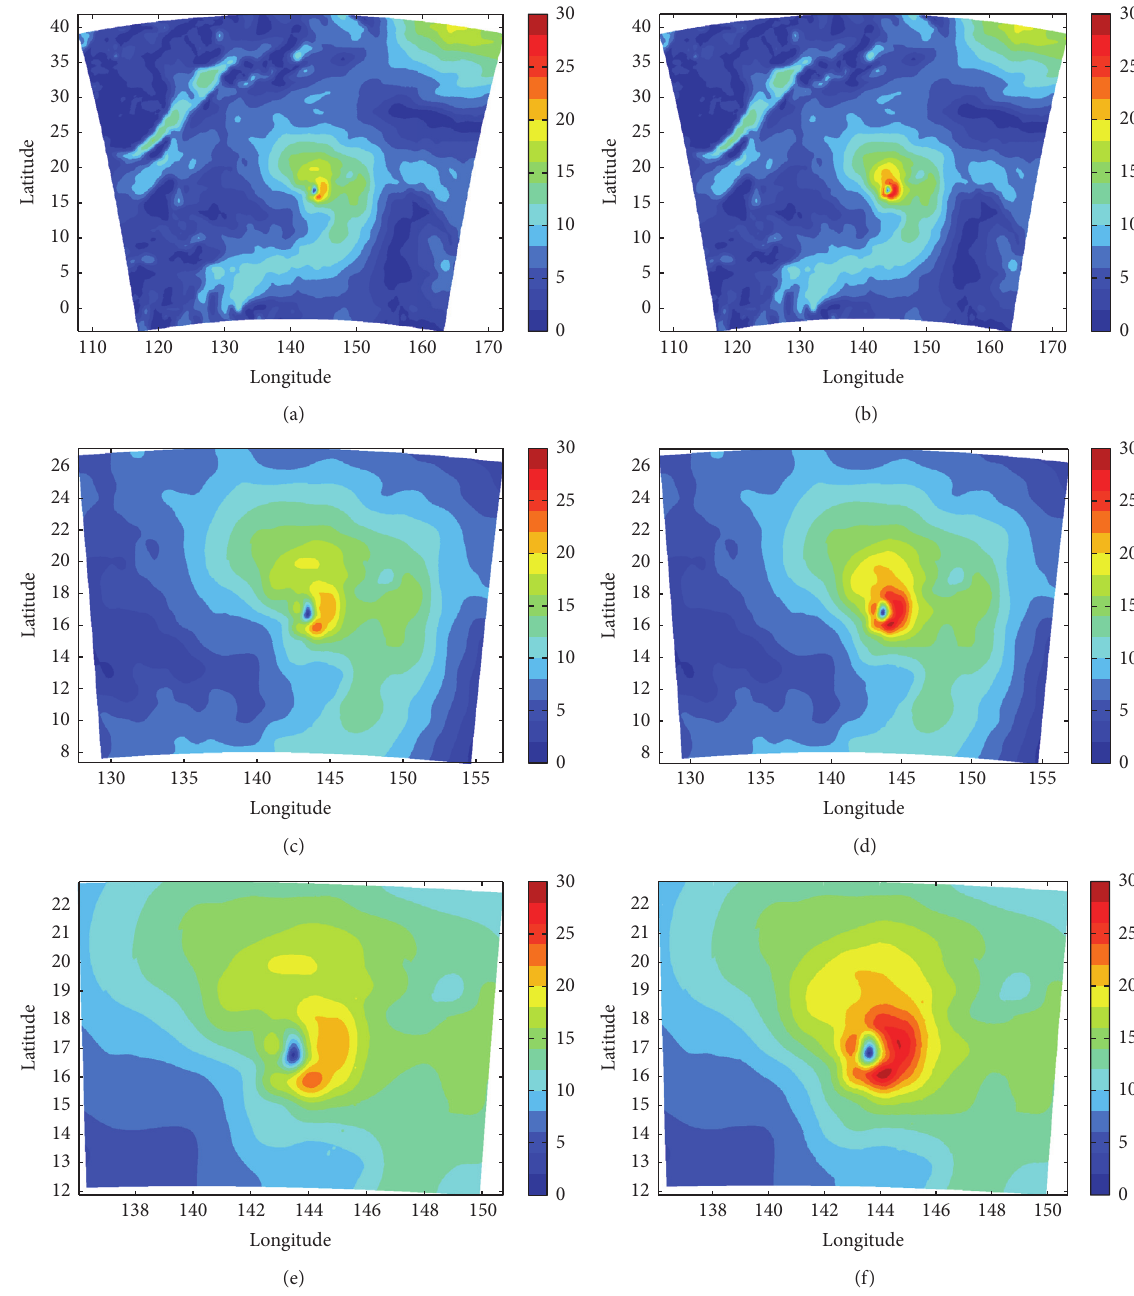
Figure 1: Phanfone: (a) WSP 𝑠 before initialization in D01 (27km); (b) WSP 𝑠 after initialization in D01 (27km); (c) WSP 𝑠 before initialization in D02 (9 km); (d) WSP 𝑠 after initialization in D02 (9km); (e) WSP 𝑠 before initialization in D03 (3km); and (f) WSP 𝑠 after initialization in D03 (3km). The unit in these figures is